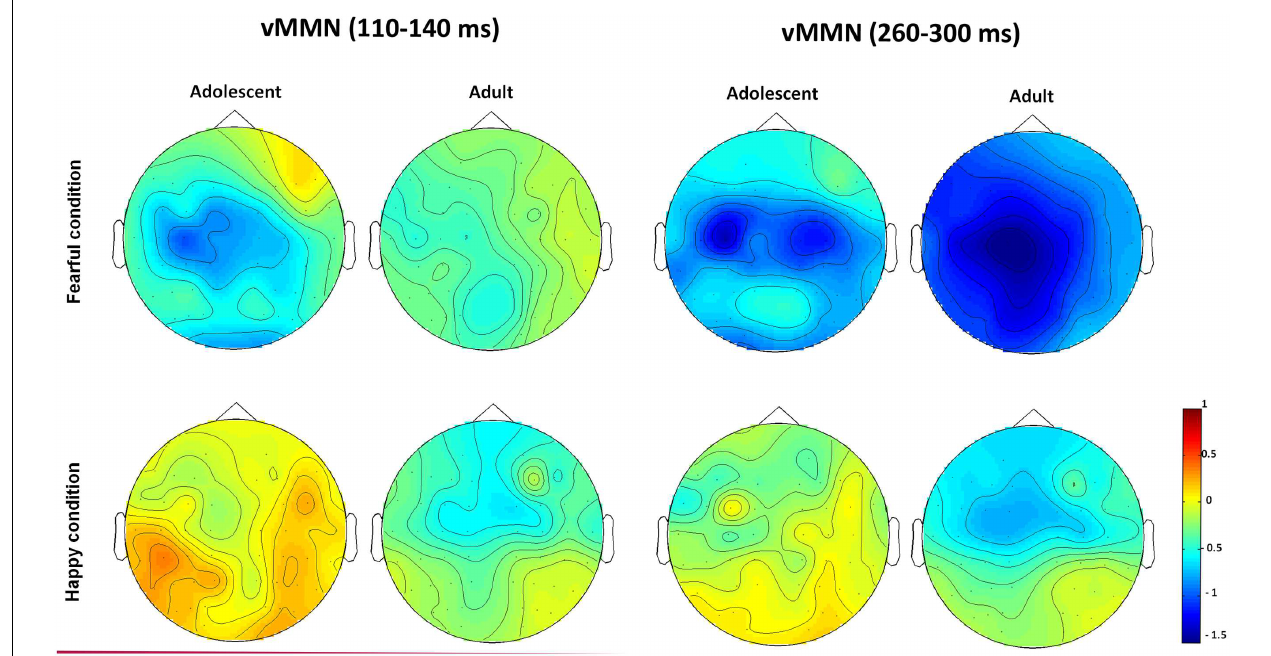
FIGURE 4 | The topographic maps of the vMMNs for both adolescent and adult groups in the happy and fearful